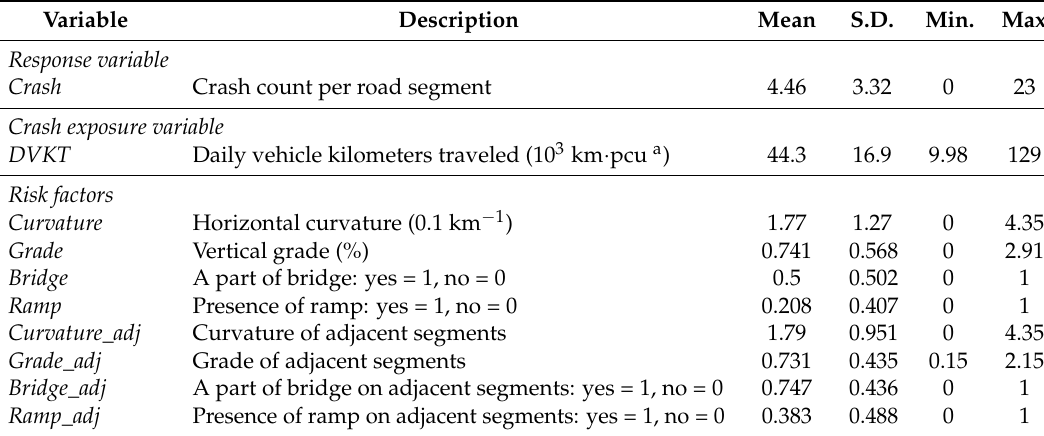
Table 1. Definitions and descriptive statistics of collected